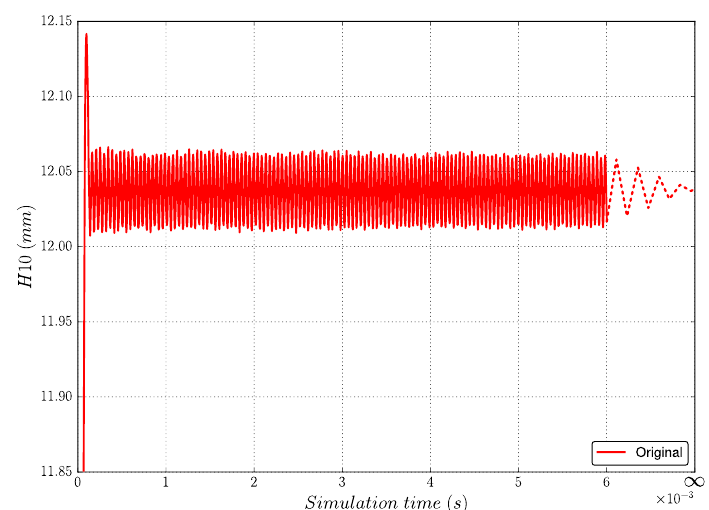
Figure 5. H 10 vs. time plot of the dynamic tensile